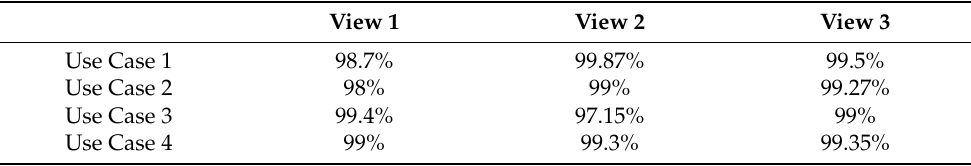
Table 1. Summary of STPS Gait Recognition Results for Use Cases and